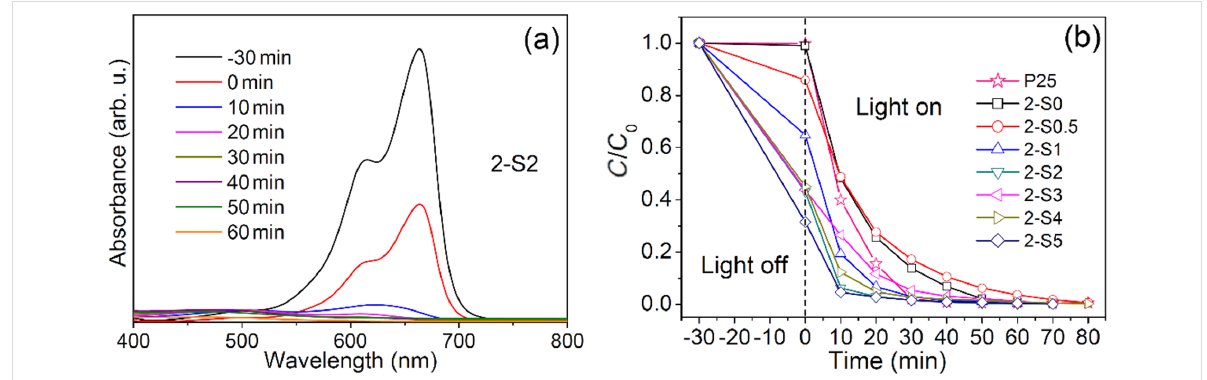
Figure 7: The temporal evolution of the UV–Vis spectra during the photodegradation of aqueous MB over the sample 2-S2 (a) and the variation of the MB concentration C / C 0 with time in the presence of 2-S0, 2-S0.5, 2-S1, 2-S2, 2-S3, 2-S4 and 2-S5 and commercial P25 TiO 2 irradiated by a xenon lamp (b).